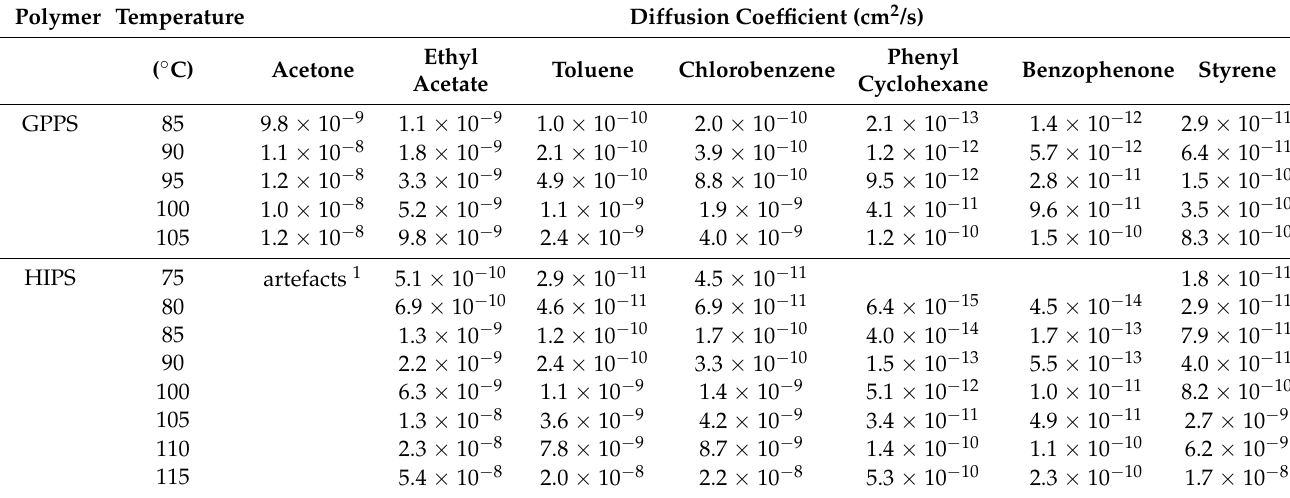
Table 4. Experimentally determined diffusion coefficients of n -alkanes and styrene in polystyrene GPPS and HIPS (sheet 2) from desorption